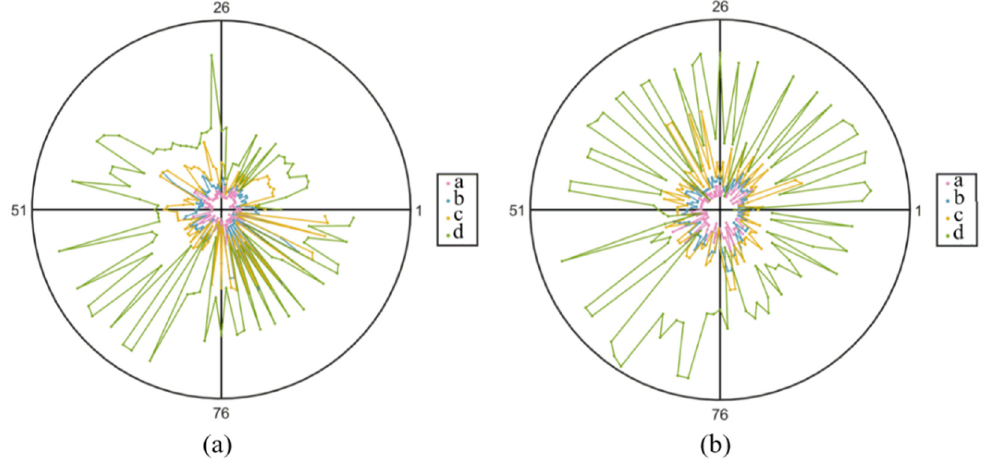
Figure 10. ( a ) “parrots” polar graph of edge information; ( b ) “planes” polar graph of edge infor- mation.